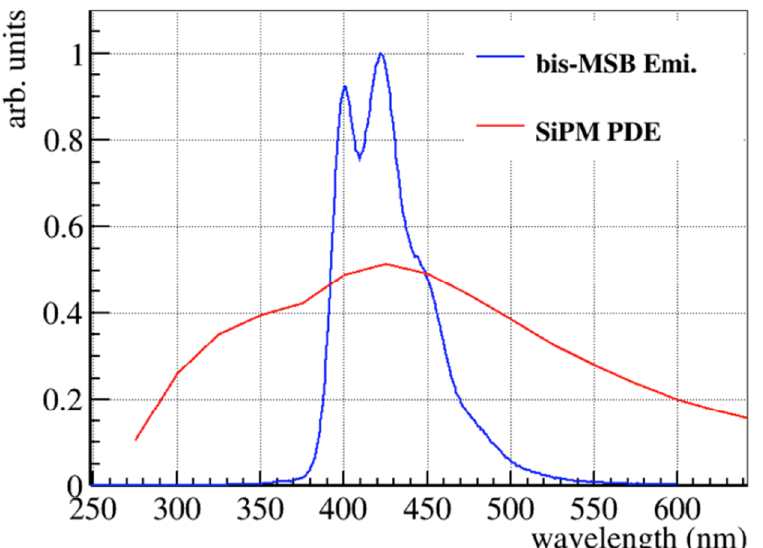
Figure 2. The effective emission spectrum of BisMSB (blue) dissolved in cyclohexane under excitation with UV light in a 10 mm × 10 mm × 40 mm quartz glass cuvette. The red graph represents a typical spectral response spectrum of a TAO-like SiPM at −50 °C matching well the BisMSB emission.